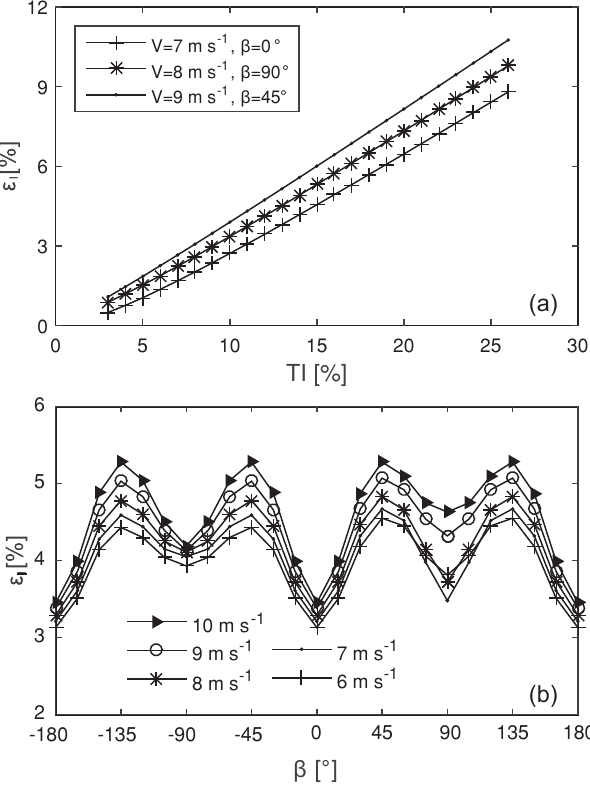
Figure 3. Dependence of the relative standard error ( ε l ) of wind speed estimated from arc scans on (a) turbulence intensity (TI) and (b) wind speed ( V 0 ) and direction (expressed as the relative direc- tion ( β )) based on the isotropic turbulence model given in Eq. (10) for the following scan geometry: φ = 16 . 7 ◦ , (cid:49)θ = 30 ◦ , δθ = 6 ◦ and r = 313m. The Coriolis parameter f 0 = 0 . 0001s − 1